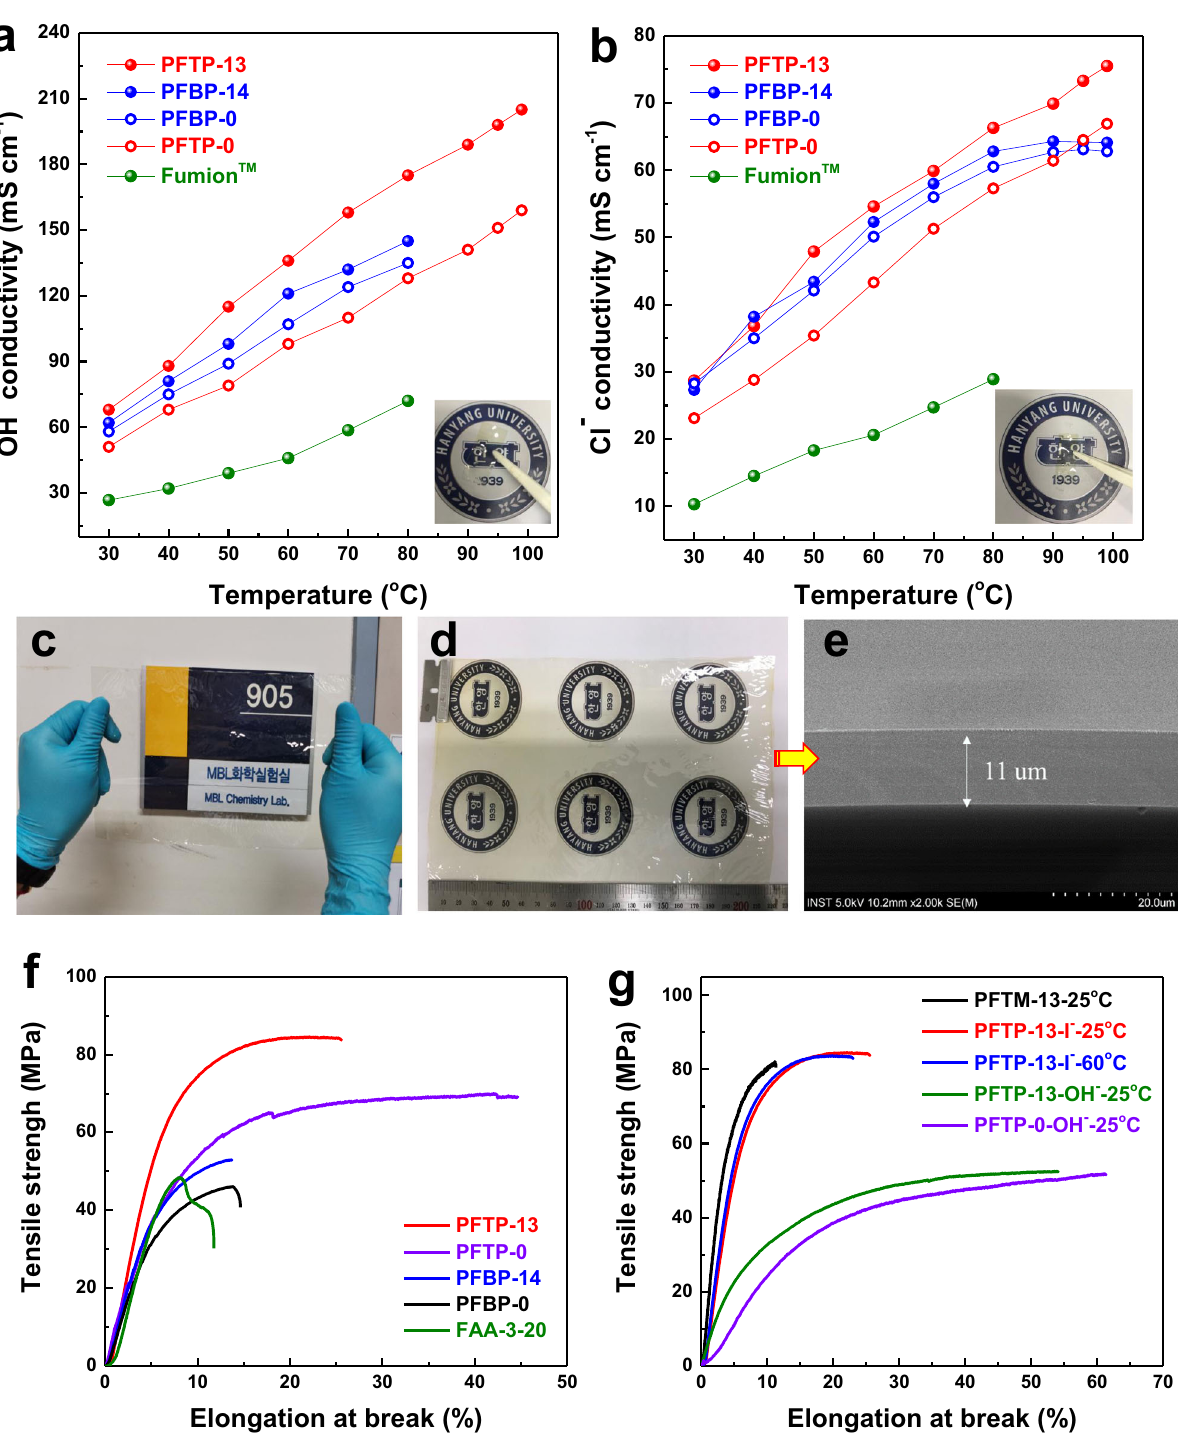
Fig. 3 Physical properties of AEMs. a OH − and b Cl − conductivity of different AEMs as a function of temperature along with the picture of PFTP-13 membranes after testing at 98 °C. PFBP-14 and PFBP-0 membranes showed poor dimensional stability at high temperatures, and thus it was dif fi cult to measure their OH − conductivities over 90 °C. c , d A picture of transparent PFTP-13 membranes 13.5 × 22.5 cm in size. e SEM image of a cross-section of PFTP-13 membrane with a thickness of ~15 µ m. f The TS and EB of AEMs in I − form and commercial FAA-3-20 membranes at room temperature. Compared to the present PFTP-0 AEMs (TS: 71 MPa, EB: 45.7%, YM: 1.2 GPa) and reported PAP-TP-x AEMs (TS: 67 MPa and EB:117%) 17 , PFTP-13 AEMs exhibit much higher TS and YM but lower EB, indicating that the PFTP-13 AEMs have a higher deformation resistance. g The tensile strength and elongation at break of PFTP-13 and PFTP-0 membranes at different temperatures and types. PFTM-13 is PFTP-14 before quaternization, whereas PFTP-13-I − and PFTP- 13-OH − are in I − and OH − forms, respectively. PFTP-13 AEMs maintain their mechanical properties at 60 °C. Compared to Peng et al. ’ s PFTP-0 AEMs 36 (TS: 35 MPa and EB: 40%), the present PFTP-13 and PFTP-0 AEMs (TS: > 50 MPa and EB: ~60%) in OH − form exhibit much higher mechanical properties due to their higher intrinsic